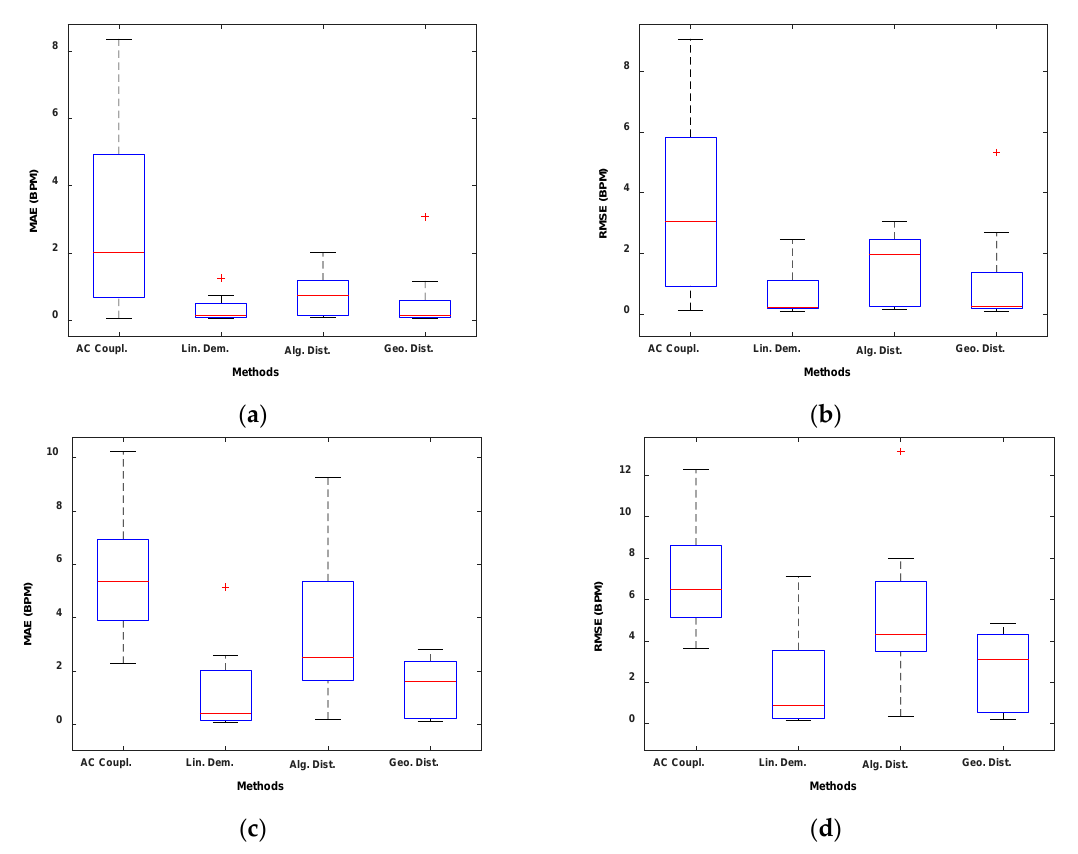
Figure 2. Boxplots of the experimental validation using the sub-10 GHz radar. ( a ) MAE RR. ( b ) RMSE RR. ( c ) MAE HR. ( d ) RMSE HR.